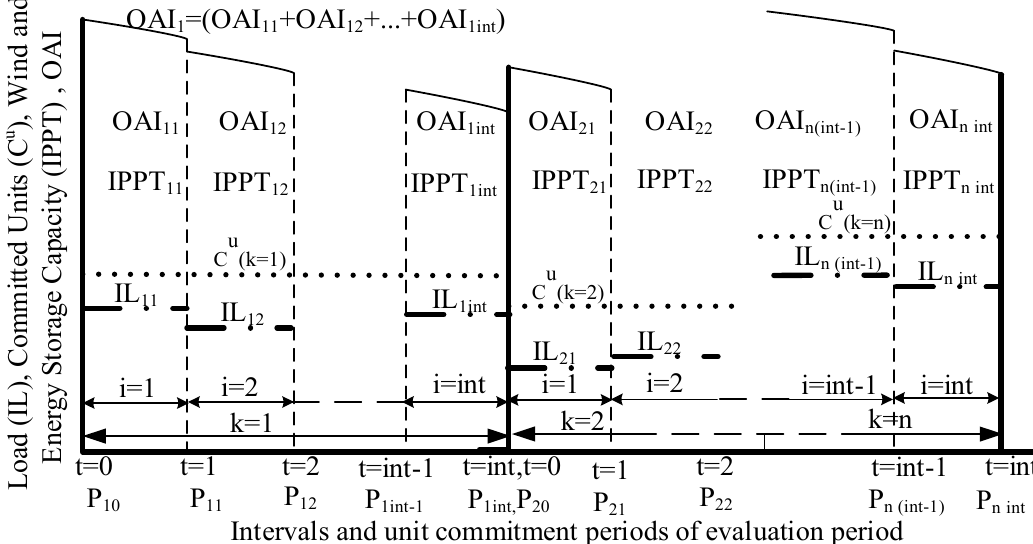
Figure 3. Risk area curves of a wind and energy storage system (ESS) integrated bulk power system within the evaluation period.